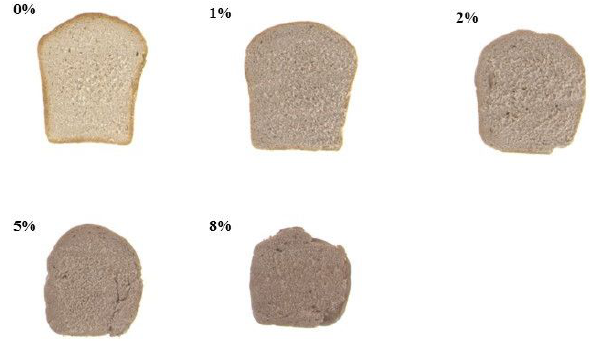
Figure 5: The shape and color of the bread samples replaced with different levels of GSMP (0%, 1%, 2%, 5%, 8%) acquired by the e-eye